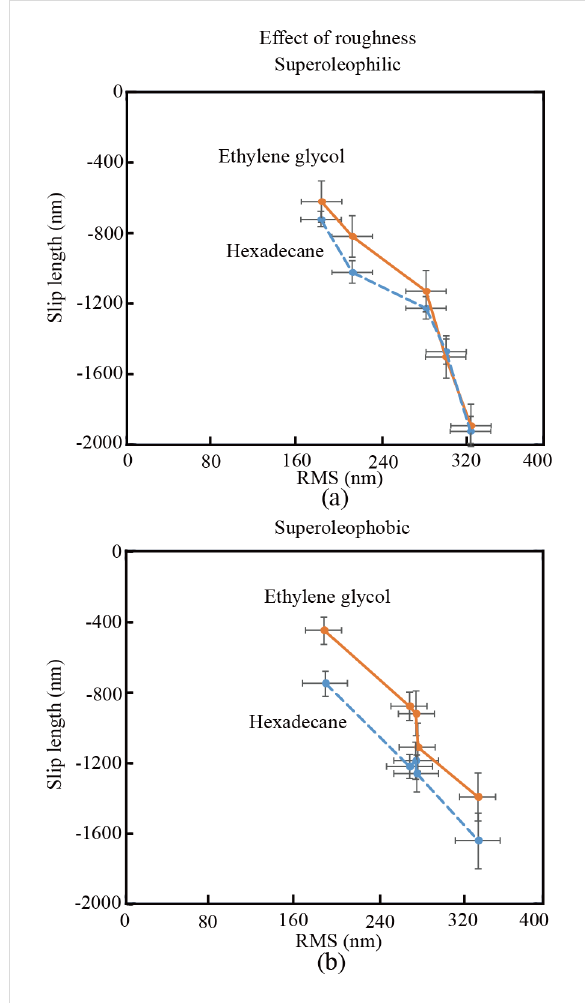
Figure 7: Measured slip length on (a) superoleophilic and (b) super- oleophobic surfaces with varying values of RMS roughness immersed in hexadecane and ethylene glycol.